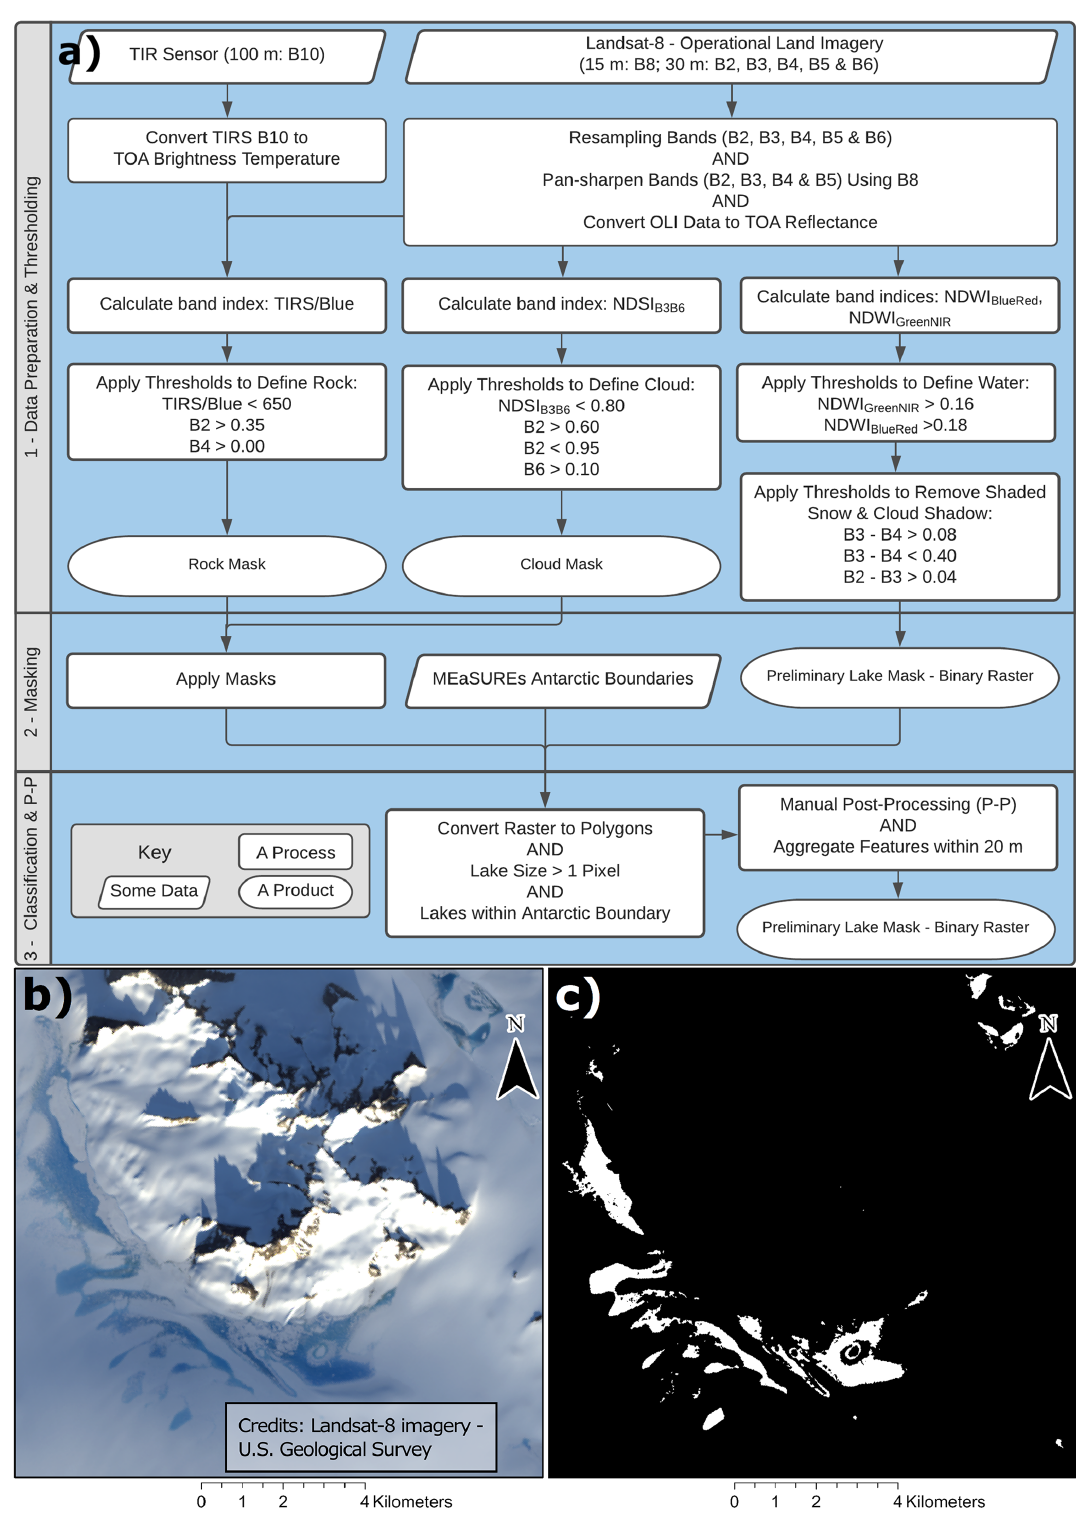
Figure 3. L8 processing chain (a) . The input files are the L8 Operational Land Imager (OLI) and Thermal Infrared Sensor (TIRS) products (RGB composite of tile LC08_L1GT_192129_20170118 from 18 January 2017 on Pine Island Glacier b ), and the output is the final supraglacial lake and channel dataset (c) in raster and vector format. Imagery was accessed from US Geological